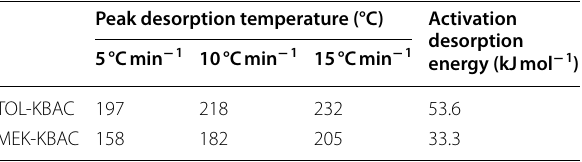
Table 3 Peak desorption temperature and activation desorption energy derived from DTG for TOL‑KBAC and